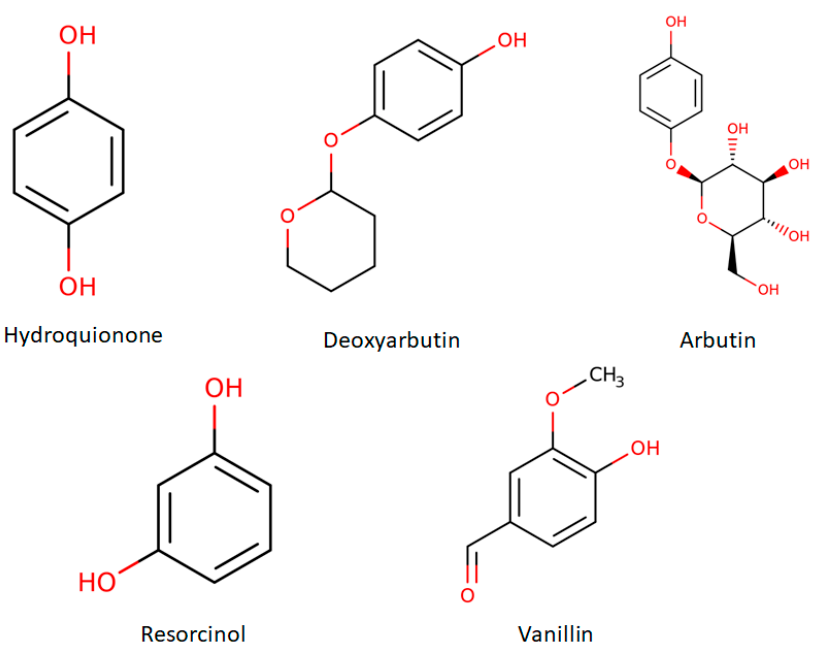
Figure 2. Chemical structures of phenolic derivatives.